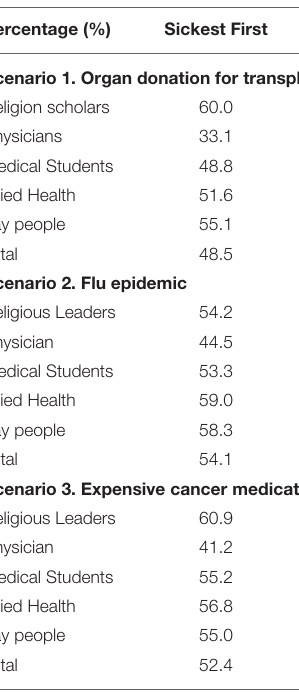
Scenario 2. Flu epidemic